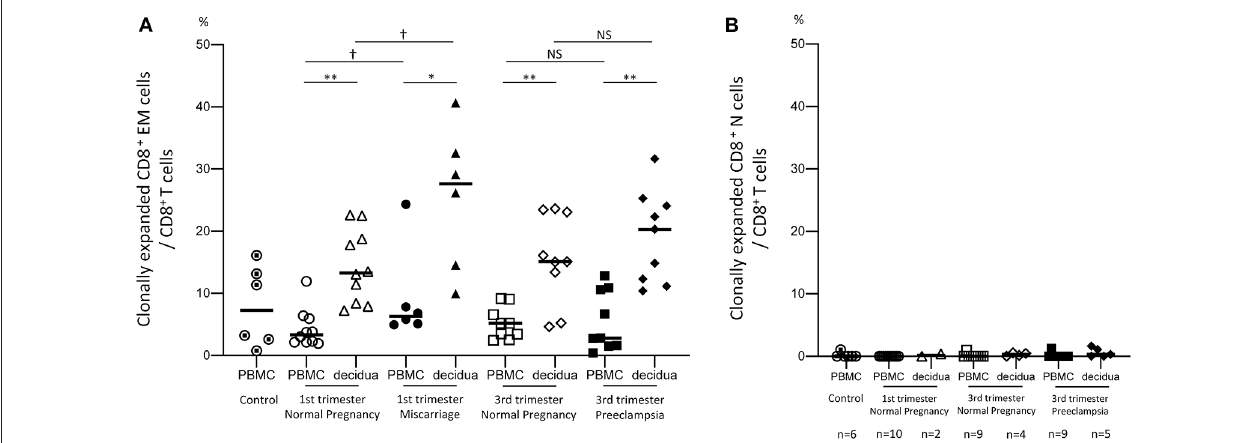
FIGURE 2 | Clonal populations of CD8 + EM and CD8 + N cells among total CD8 + T cells. Clonally expanded CD8 + EM cells (A) and CD8 + N cells (B) among CD8 + T cells. Due to their small amount, CD8 + N cells could not be sorted in all samples. The number of cases analyzed in each group is shown under the horizontal axis. Statistical analysis was performed in CD8 + EM cells (A) by using Wilcoxon matched-pairs single rank test (PBMC vs. decidua in each group); * p < 0.05; ** p < 0.01. Mann-Whitney U test (control vs. 1st or 3rd trimester normal pregnancy. 1st vs. 3rd trimester normal pregnancy, 1st trimester normal pregnancy vs. miscarriage, 3rd trimester normal pregnancy vs. preeclampsia); † p < 0.05; NS not